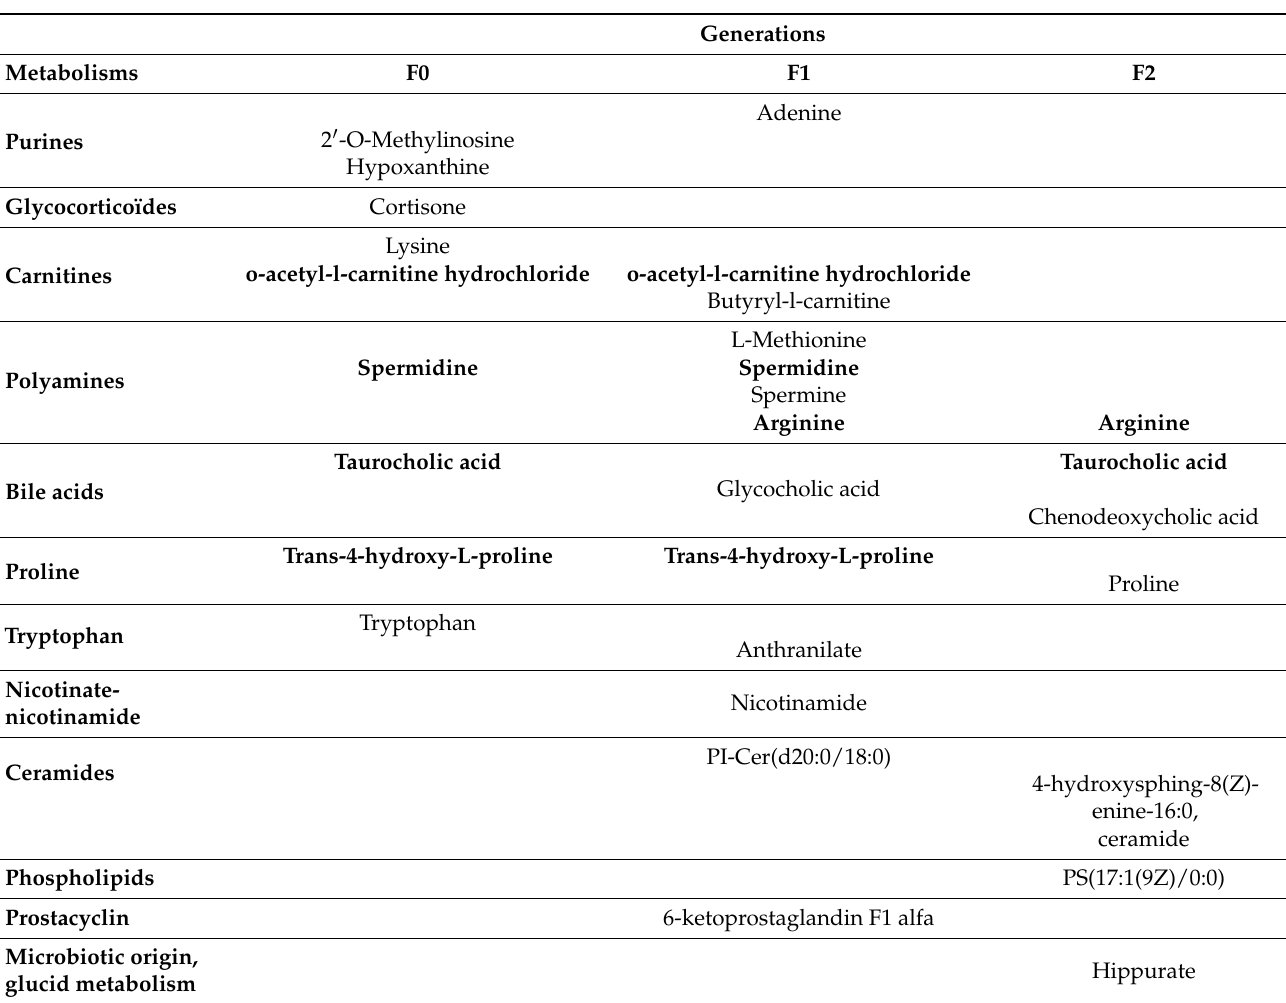
Table 1. Main related pathways identified from the most discriminant metabolites in each